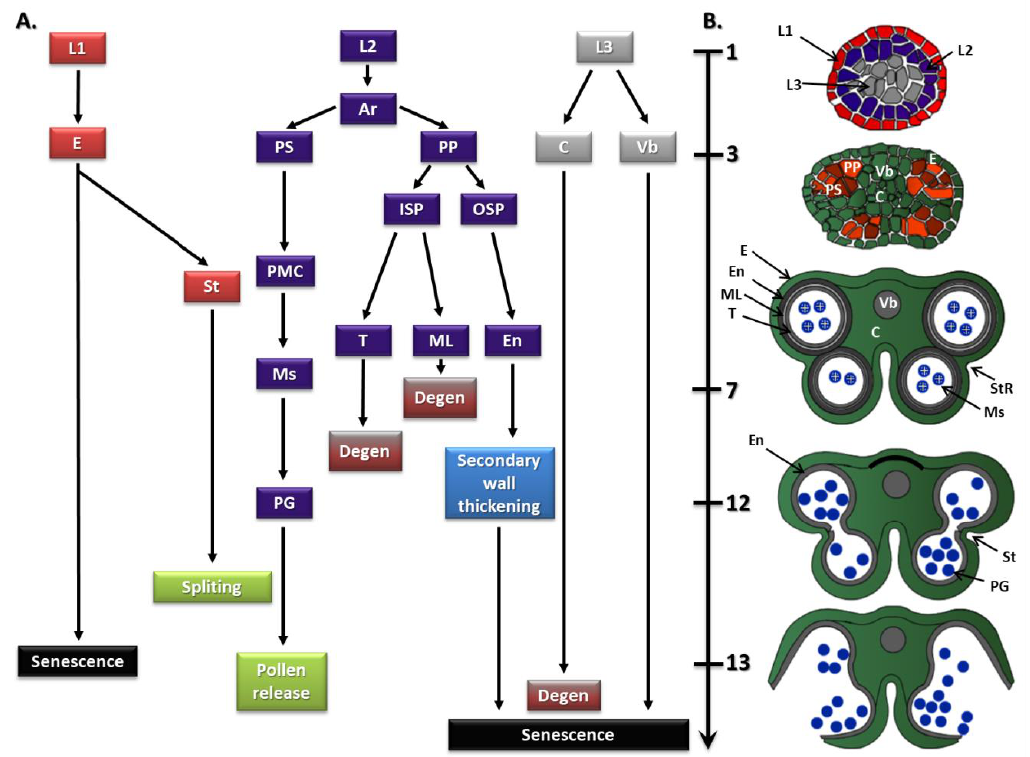
Figure 2. The cell lineages model for the origin of the cell layers in the anther ( A ) and anther structure at di ff erent stages of development ( B ) in A. thaliana . Initially, divisions in the L1, L2, and L3 layers of the floral meristem lead to the formation of the stamen primordia. Divisions in the L1 layer form the epidermis (E), stomium region (StR), and stomium (St), while L3 cells divide to form connective (C) and vascular bundle (Vb). Periclinal divisions of the L2 cells result in the formation of archesporial cells (Ar). Next, Ar divide to form the primary (1 ◦ ) sporogenous layer (PS) and the primary (1 ◦ ) parietal layer (PP). Then, the PS layer undergoes divisions to form pollen mother cells (PMC), microspores (Ms) and, finally, mature pollen grains (PG). The PP layer goes through a further division to form two secondary (2 ◦ ) parietal layers, the inner secondary parietal layer (ISP) and the outer secondary parietal layer (OSP). The OSP divides again and di ff erentiates to form the endothecium (En), whereas the ISP divides and develops to form the tapetum (T) and middle layer (ML) [17–20].